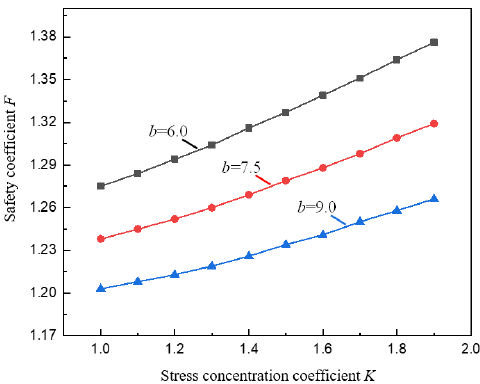
Figure 7. Variation curve of pillar safety coefficient F with stress concentration coefficient K .